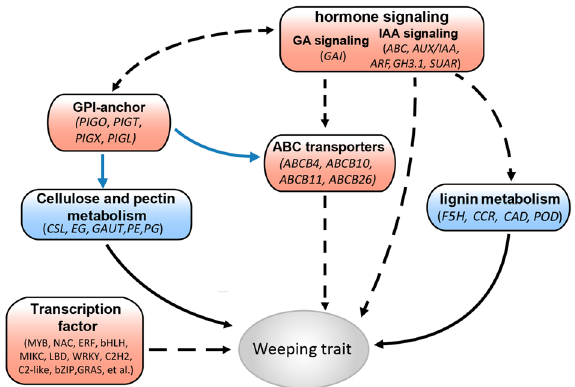
Figure 7. Summary of transcription-level regulation of the formation of the weeping trait in P. mume. The solid black line indicates direct control, the black dotted line indicates indirect regulation, and the solid blue line indicates post-transcriptional modification of